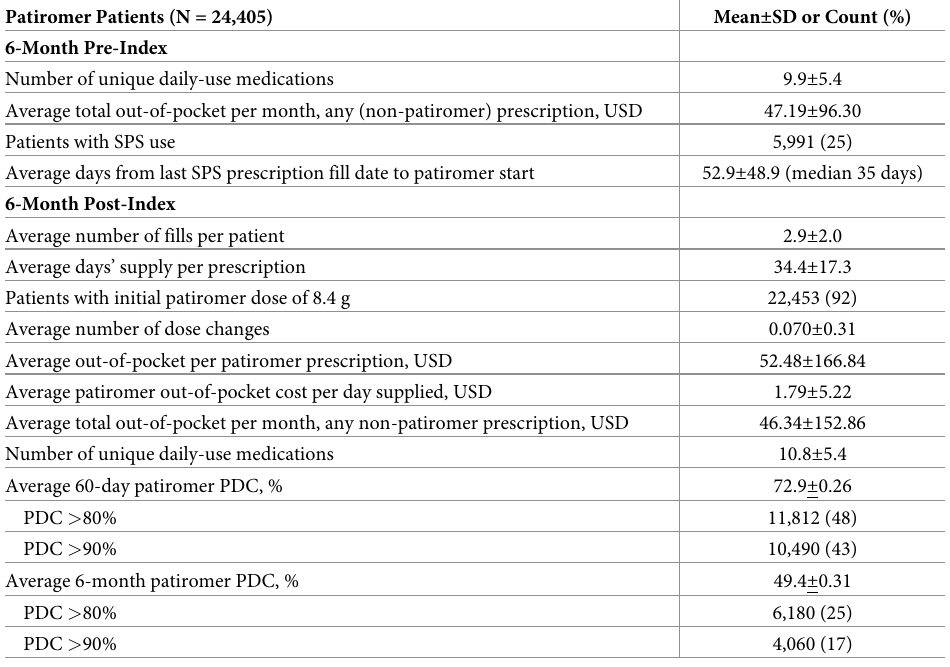
Abbreviations: PDC, proportion of days covered; SD, standard deviation; SPS, sodium polystyrene sulfonate; USD, United States